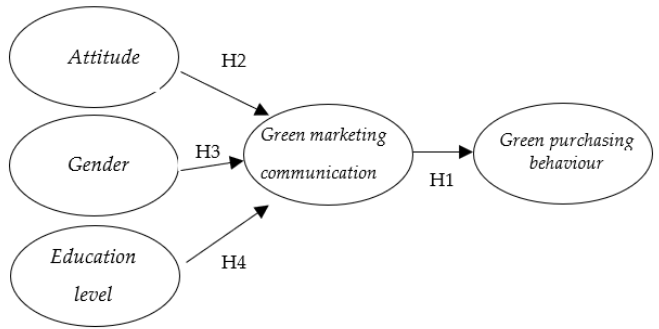
Figure 1. Proposed research model.